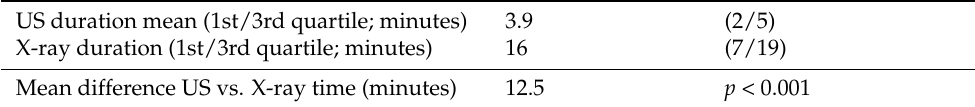
Table 3. Duration of POCUS and X-ray imaging.